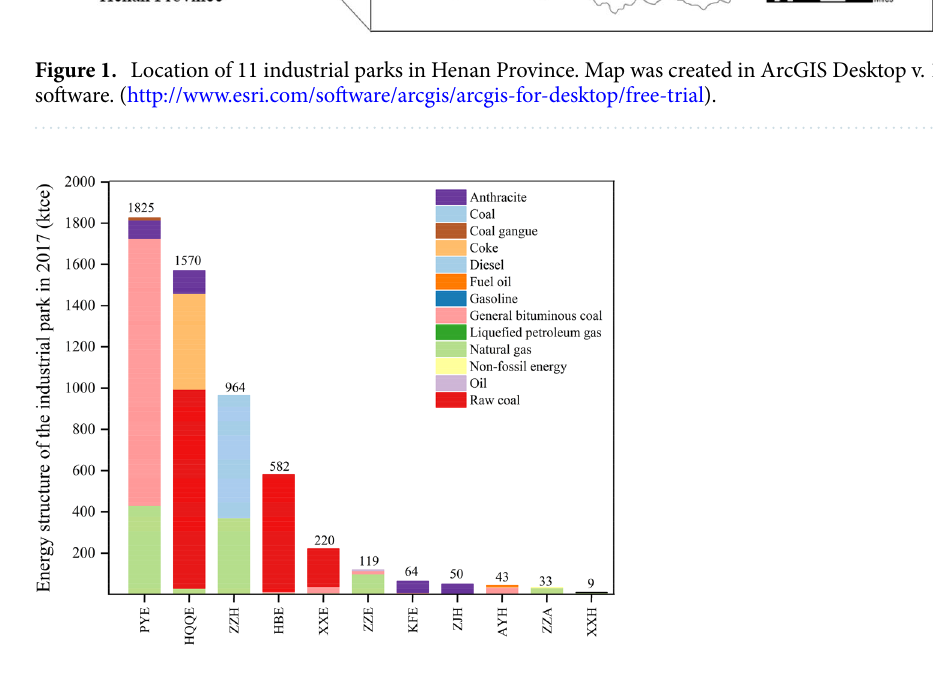
Figure 2. The energy consumption and structure of 11 industrial parks and proportion of energy consumption of each park to the overall energy usage in these industrial